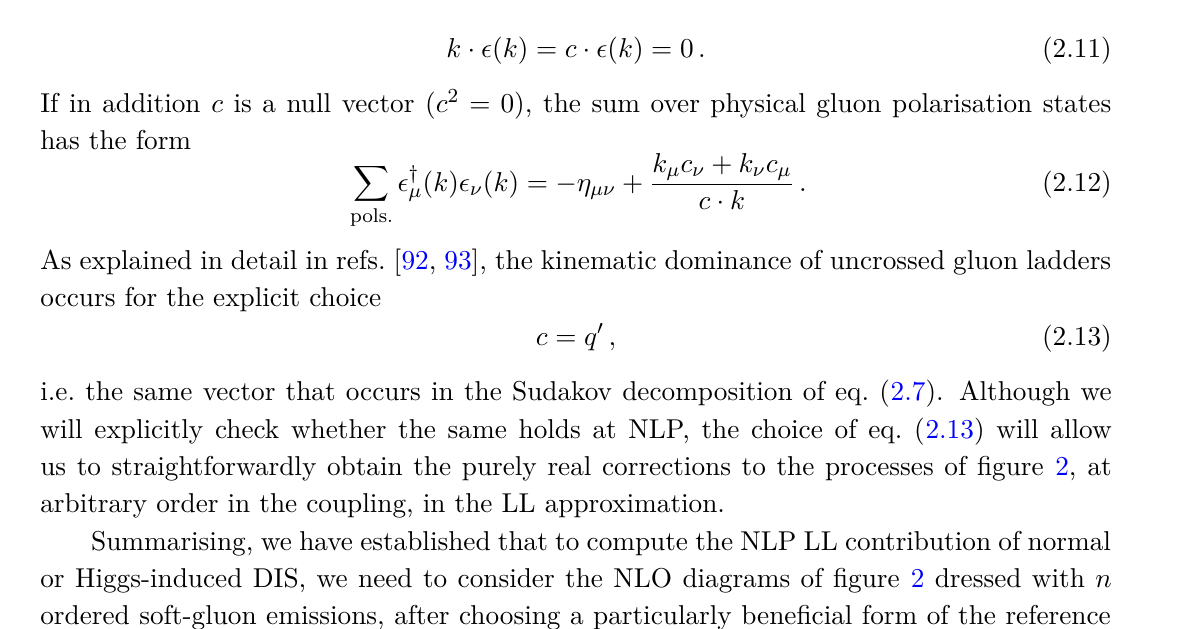
Figure 3. (a) A ladder graph contributing to the gluon channel in DIS at NLP LL; (b) a crossed- ladder